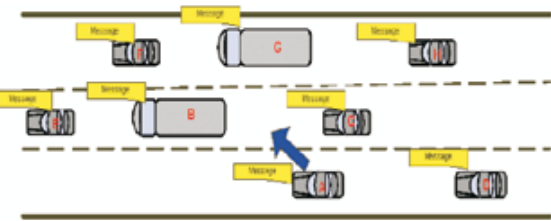
Fig. 1 . An example of beacon based safety